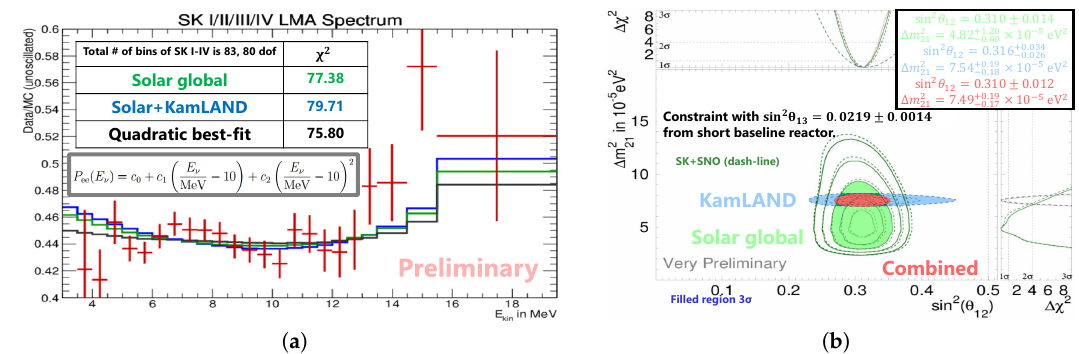
Figure 5. ( a ) The energy spectrum of recoil electrons from SK-I to SK-IV relative to the SNO NC flux (red point). The expected spectrum assuming the neutrino oscillation with the MSW (green, global solar best-fit parameters; blue, global plus KamLAND parameters). The black spectrum shows the quadratic fitting-function introduced in Ref. [75]. ( b ) Allowed region of oscillation parameters of ∆ m 2 and sin 2 θ 12